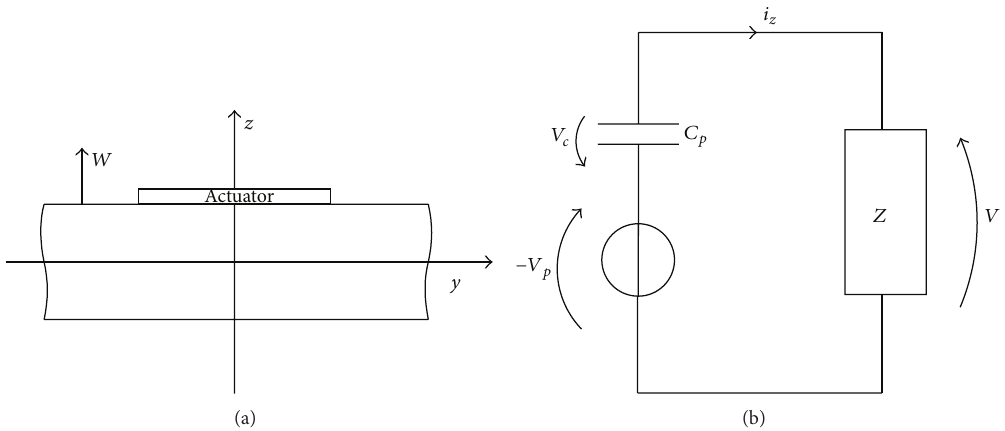
Figure 4: Structure controlled by a piezoelectric actuator shunted by the impedance 𝑍 and subject to the disturbance 𝑊 (a) and its electrical equivalent (b).